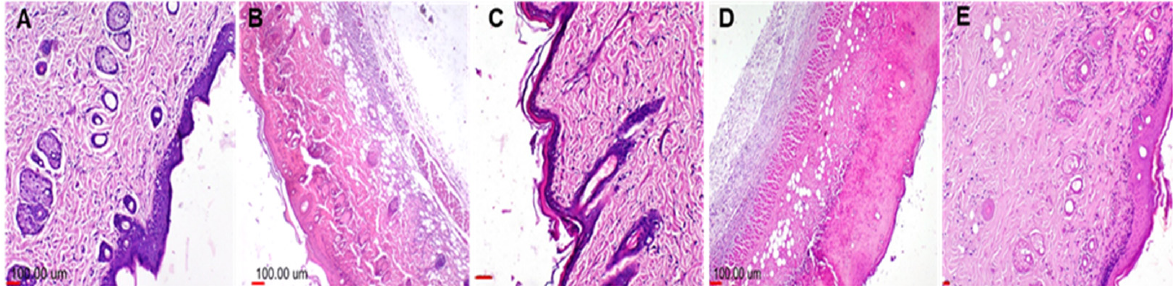
Figure 9. Representative photos of H&E-stained photomicrographs for representative rat skin of ( A ) Group I (negative control, shaved animal skin was not swapped with S. aureus , with no samples swapping), which showed normal skin tissue; ( B ) Group II (positive control, animal skin was swapped only with S. aureus , and remained untreated), which showed epidermal necrosis with ple- omorphic inflammatory cell infiltration and dead follicular sheets; ( C ) Group III (shaved animal skin was swapped with S. aureus followed by swapping with ZnO-NPs), which showed normal skin structure; ( D ) Group IV (shaved skin was swapped with S. aureus and then swapped with 3% PVP), which showed severe necrotic crust in epidermal area with massive pleomorphic inflammatory cell infiltration and vacuolar degeneration of skin muscles; and ( E ) Group V (shaved animal skin was swapped with S. aureus and then swapped with Sterillium), which showed mild inflammatory cell infiltration on the epidermal–dermal junction with limited infiltration into the dermis layer. This is indicative of the superior antibacterial activity and biosafety of ZnO-NPs compared to Sterillium. Table 5. Hirasawa scoring of histopathological alterations in skin.